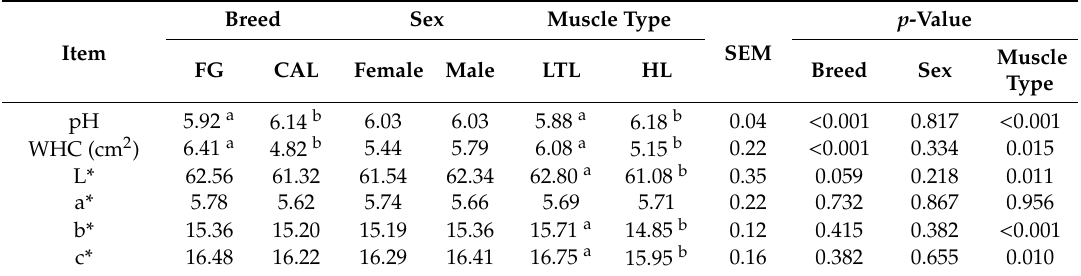
Table 6. Physicochemical properties of meat ( Longissimus thoracis et lumborum— LTL, hind leg—HL) from female and male Californian and Flemish Giant Gray rabbits (arithmetic means ± SEM).